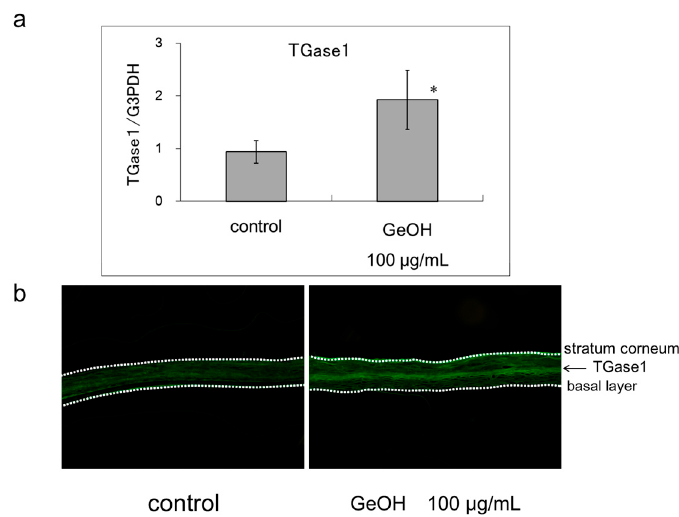
Cosmetics 2017 , 4 , 33 control. * p < 0.05 vs. control at the Δ Ct stage; ( b ) Immunohistochemical staining: After 3 days of culture of the epidermis models with or without GeOH, cryosections were stained with anti-TGase1 monoclonal antibody and Alexa Fluor 488 goat anti-mouse IgG. The results are presented as the representative result of three experiments.